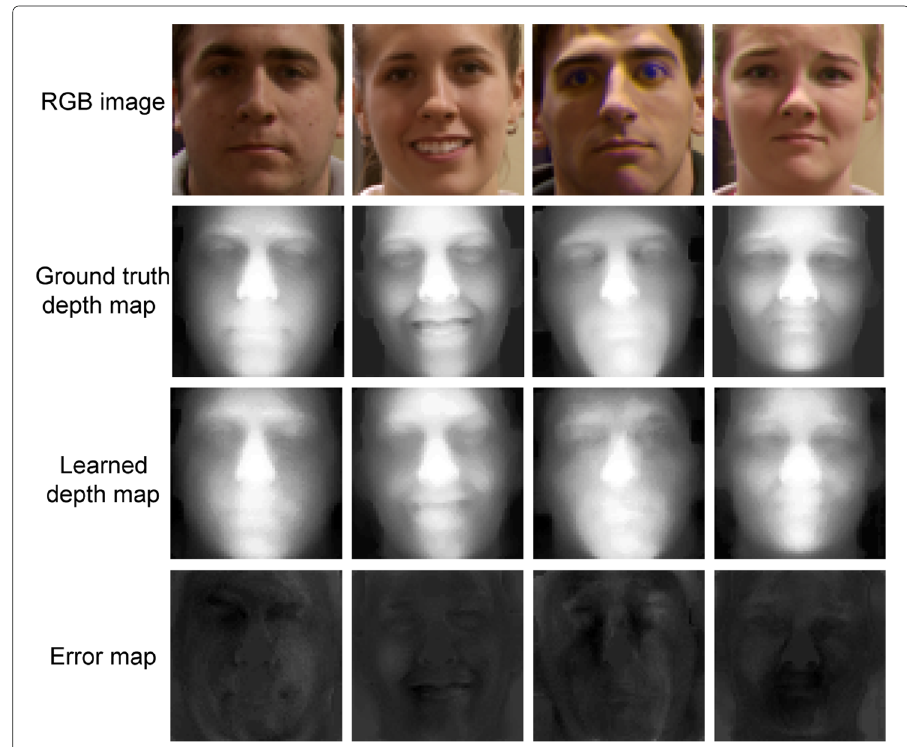
Fig. 7 Results of learned depth maps. Some examples of the learned depth maps in comparison with the ground truths. From top to bottom: the original RGB images, the supervisory depth maps (as the ground-truths), the learned depth maps, and the error maps between the learned depth maps and the ground-truths